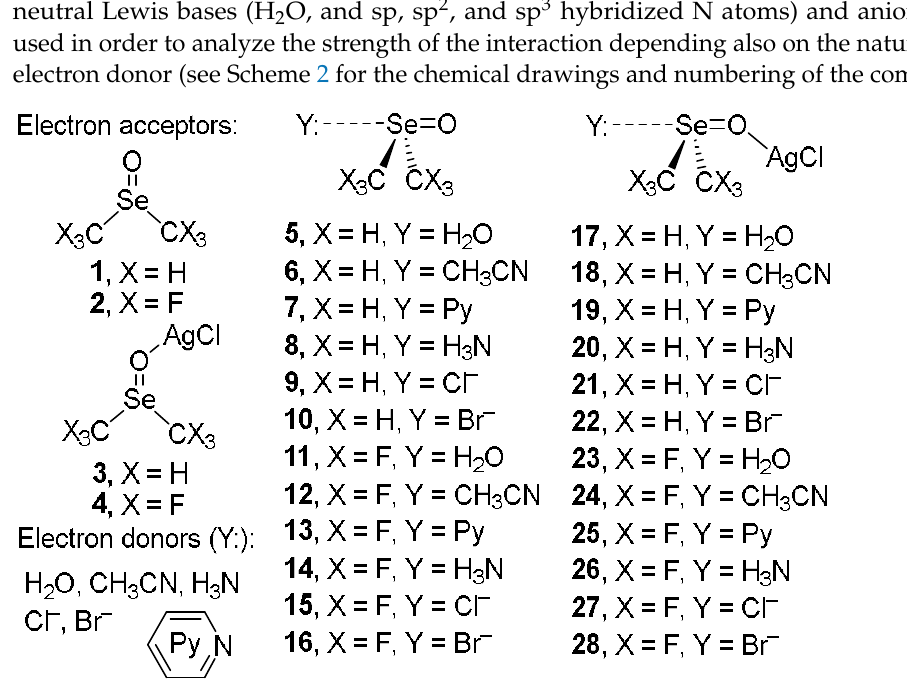
Figure 4. X-ray structures of BENYIF ( a ), RUZCIY ( b ), and YUTTOX ( c ). H atoms omitted and distances in Å.